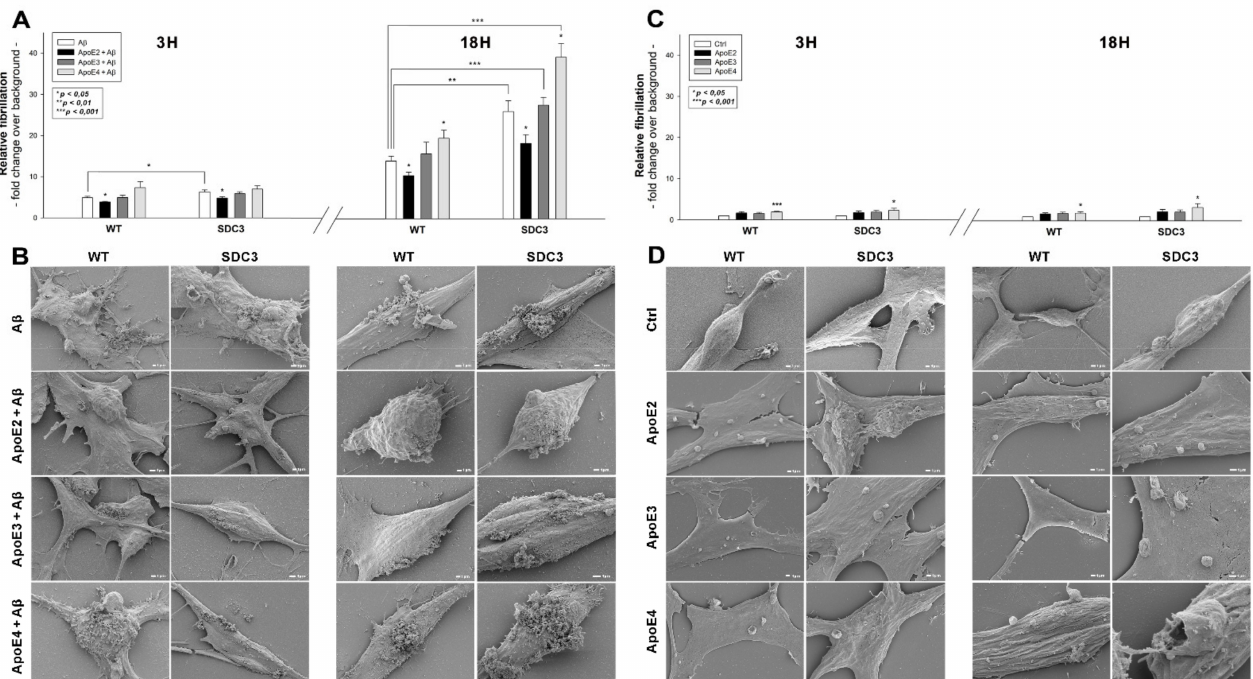
Figure 5. The effect of ApoEs on A β 1-42 fibrillation in WT and SDC3-overexpressing differentiated SH-SY5Y cells. WT and SDC3-overexpressing differentiated SH-SY5Y cells were incubated with either of the ApoE isoforms at 37 ◦ C. Thirty minutes later, some of the cells were treated with A β 1–42 and incubated for either 3 h or 18 h ( A , B ). After incubation, fibrillation was analyzed with either ThT staining or electron microscopy. ( A,C ) Results of ThT fluorescence assays after 3 h and 18 h of incubation with A β 1–42 in the presence or absence of ApoEs ( A ) or the ApoE isoforms alone ( C ). Amyloid fluorescence is expressed as fold change over background ThT fluorescence. The bars represent the mean ± SEM of four independent experiments. In the case of A β 1–42 treatment ( A ), statistical significance was assessed vs. A β 1–42-only treated cells with ANOVA. For cells receiving ApoE treatment only ( B ), statistical significance was assessed vs. untreated controls. * p < 0.05; ** p < 0.01; *** p < 0.001. ( B,D ) Scanning electron microscope visualization of WT and SDC3-overexpressing differentiated SH-SY5Y cells at 3 h and 18 h of incubation with A β 1–42 in the presence or absence of ApoEs ( B ) or the ApoE isoforms alone ( D ). Representative images of three independent experiments are shown. Scale bar = 1 µ